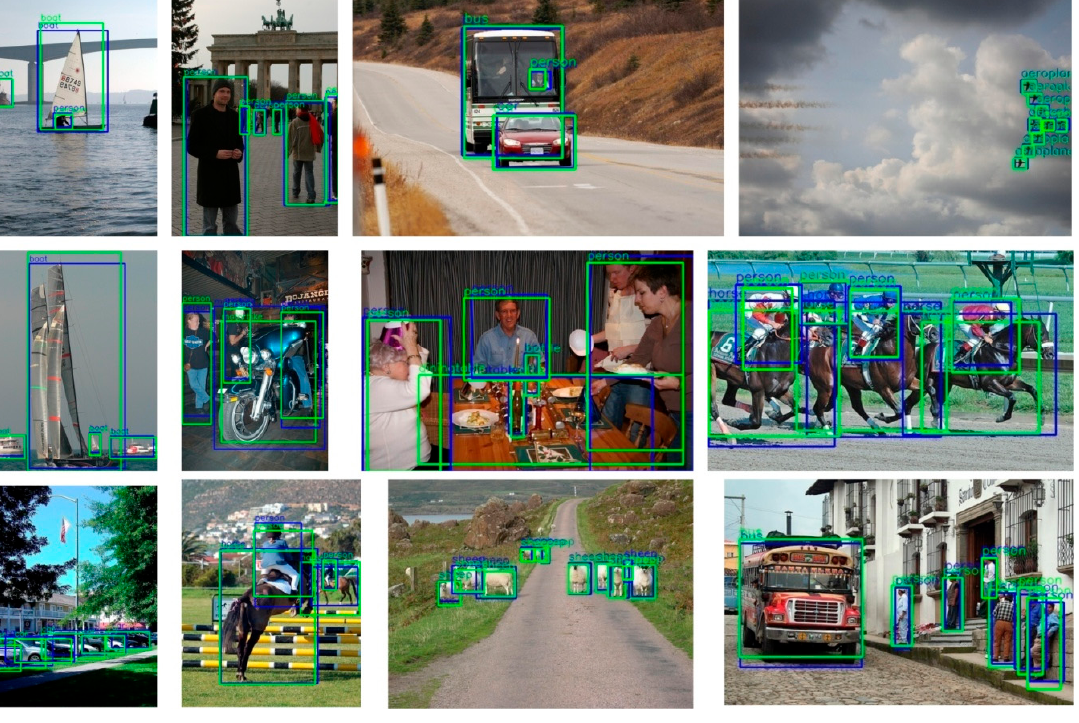
Figure 7. Test results of improved YOLO V3 on the PASCAL VOC dataset.